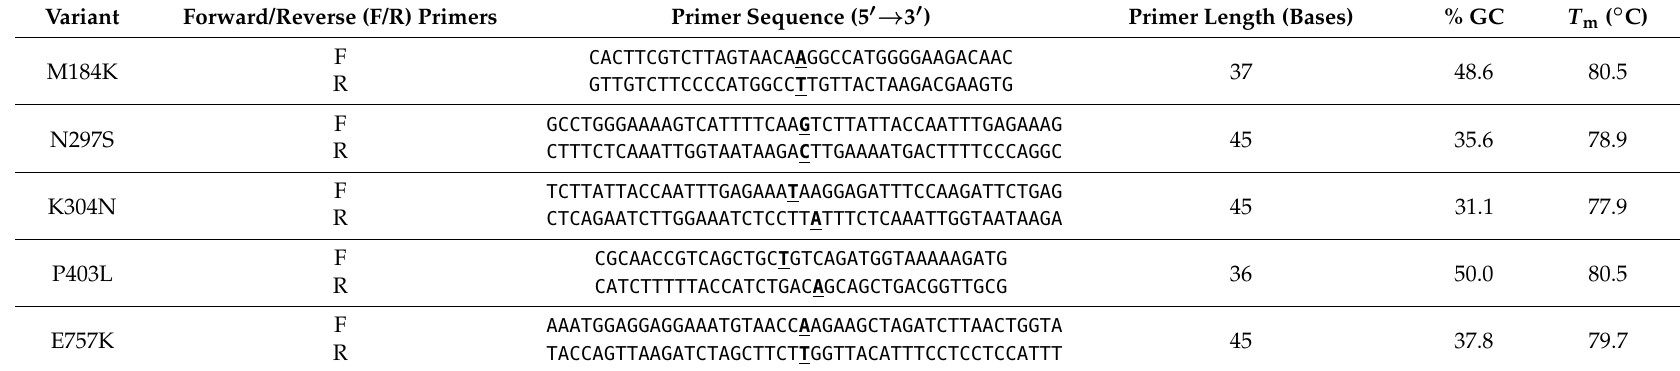
Sites of mutagenesis are underlined. % GC indicates the guanine and cytosine content in the PCR primer set. T m is the melting temperature for each PCR primer